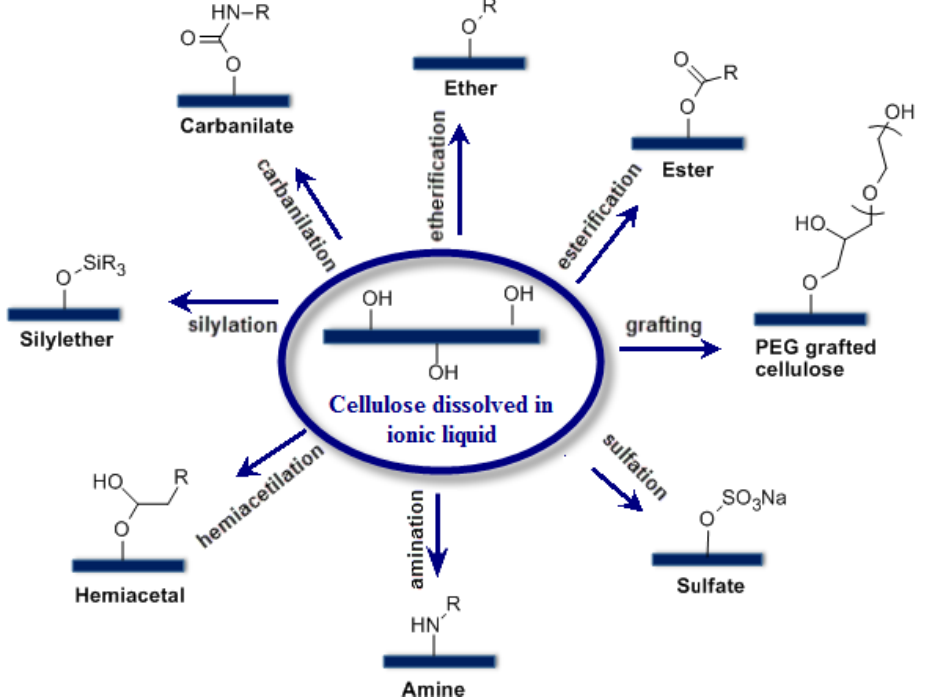
Figure 3. Possible chemical modifications that can be conducted to cellulose dissolved in ionic